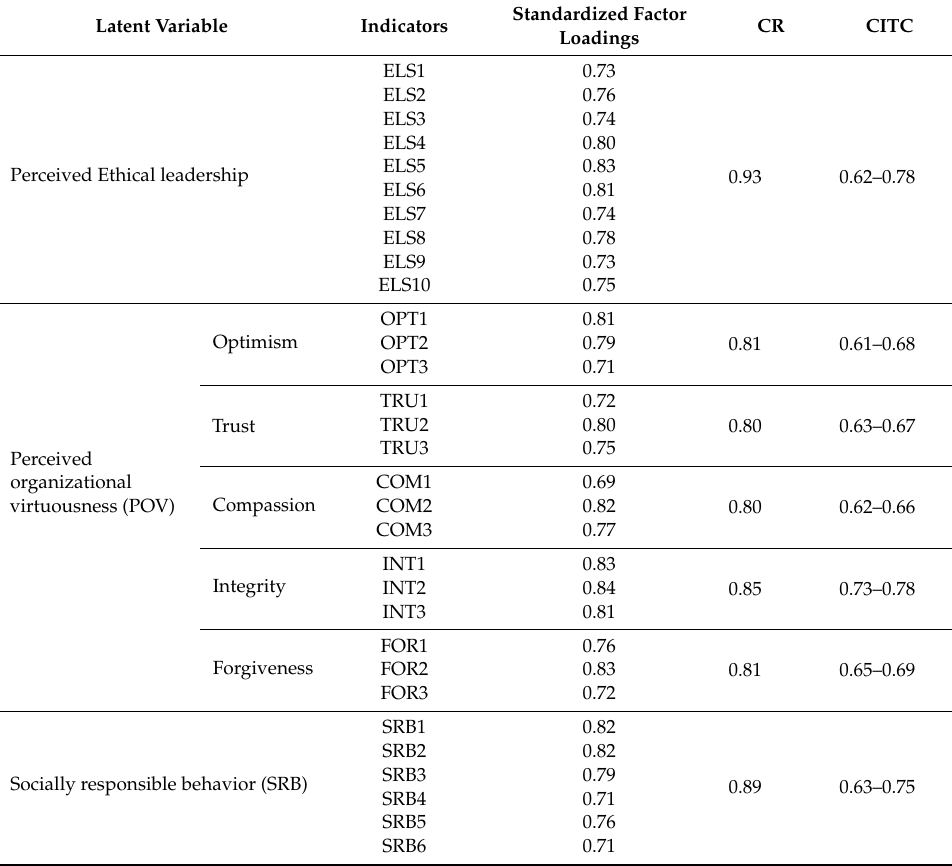
Table 2. Measurement model